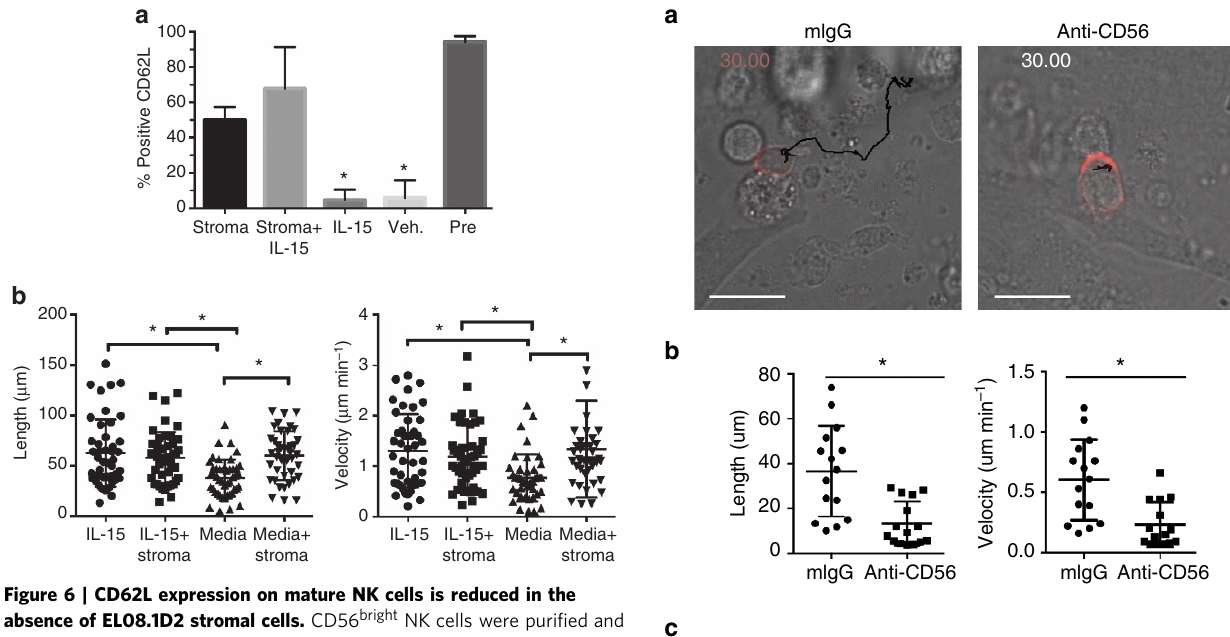
NATURE COMMUNICATIONS|7:12171|DOI: